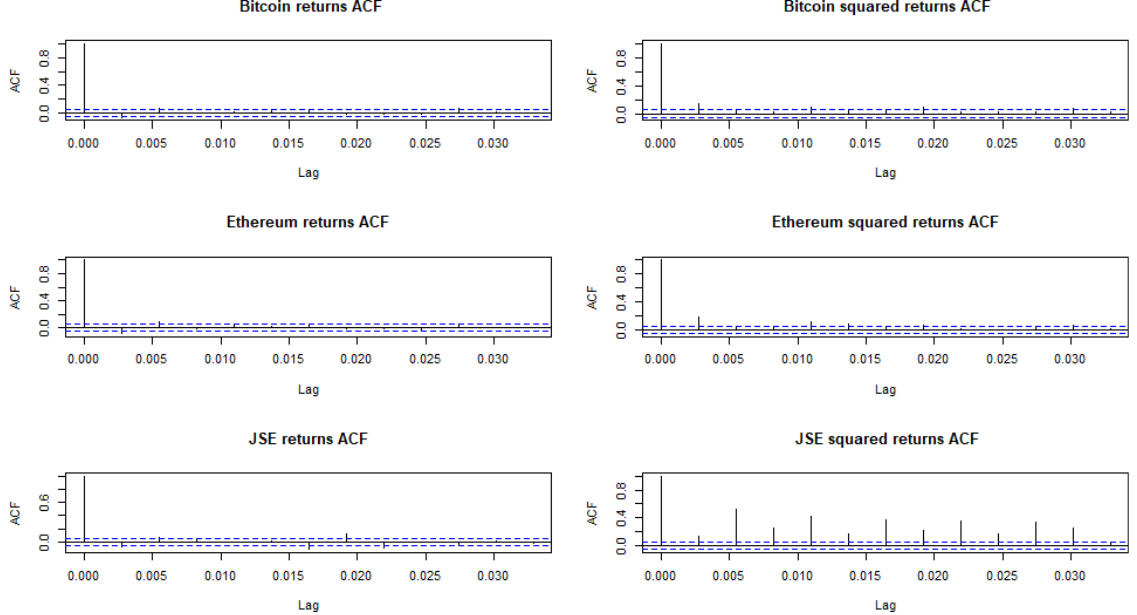
Figure 2. ACF plots of returns and squared returns